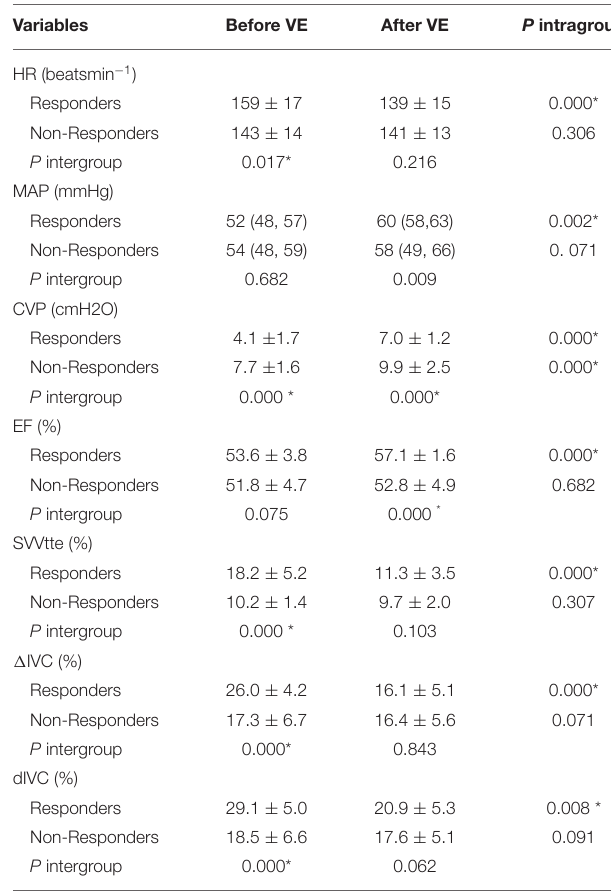
TABLE 1 | Baseline clinical characteristics and comparison between responders and non-responders (before volume expansion) quantitative data was shown as ( ¯ x ± SD) or median (25th and 75th percentiles).